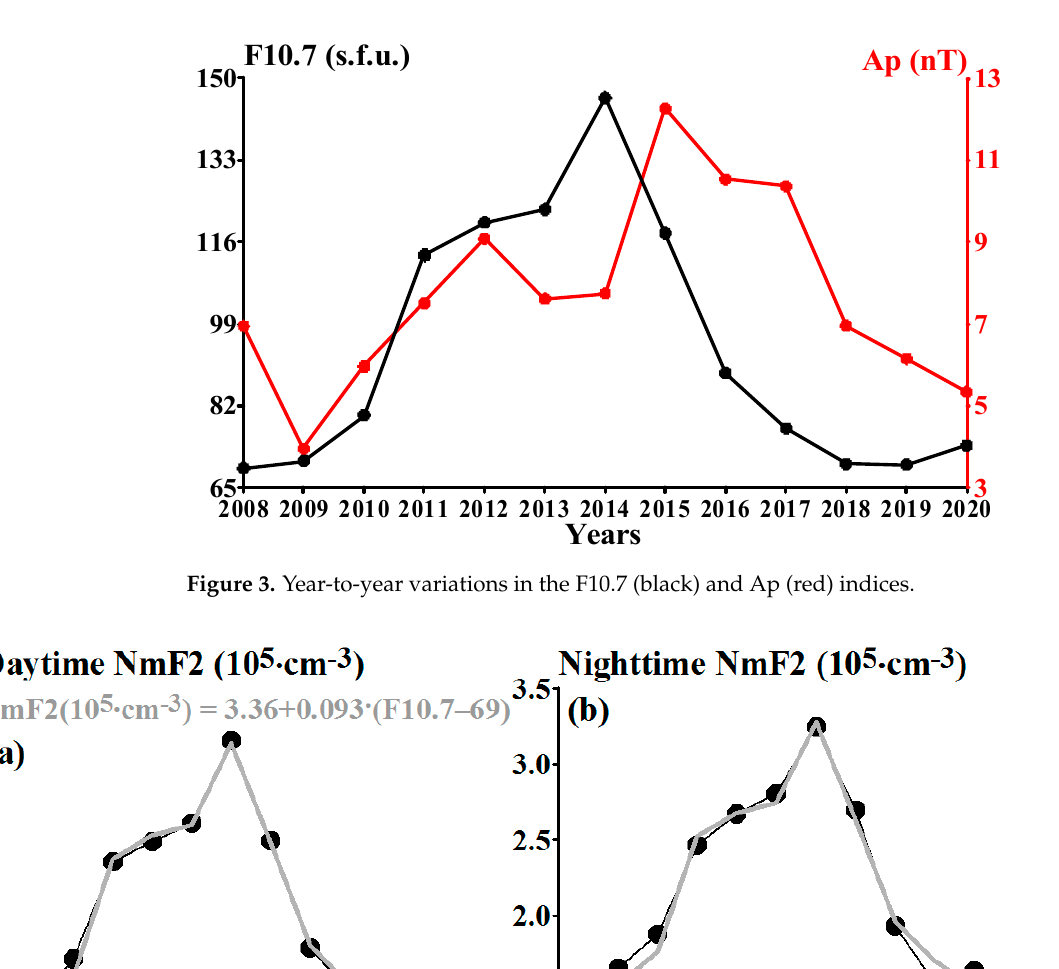
Figure 3. Year-to-year variations in the F10.7 (black) and Ap (red) indices.